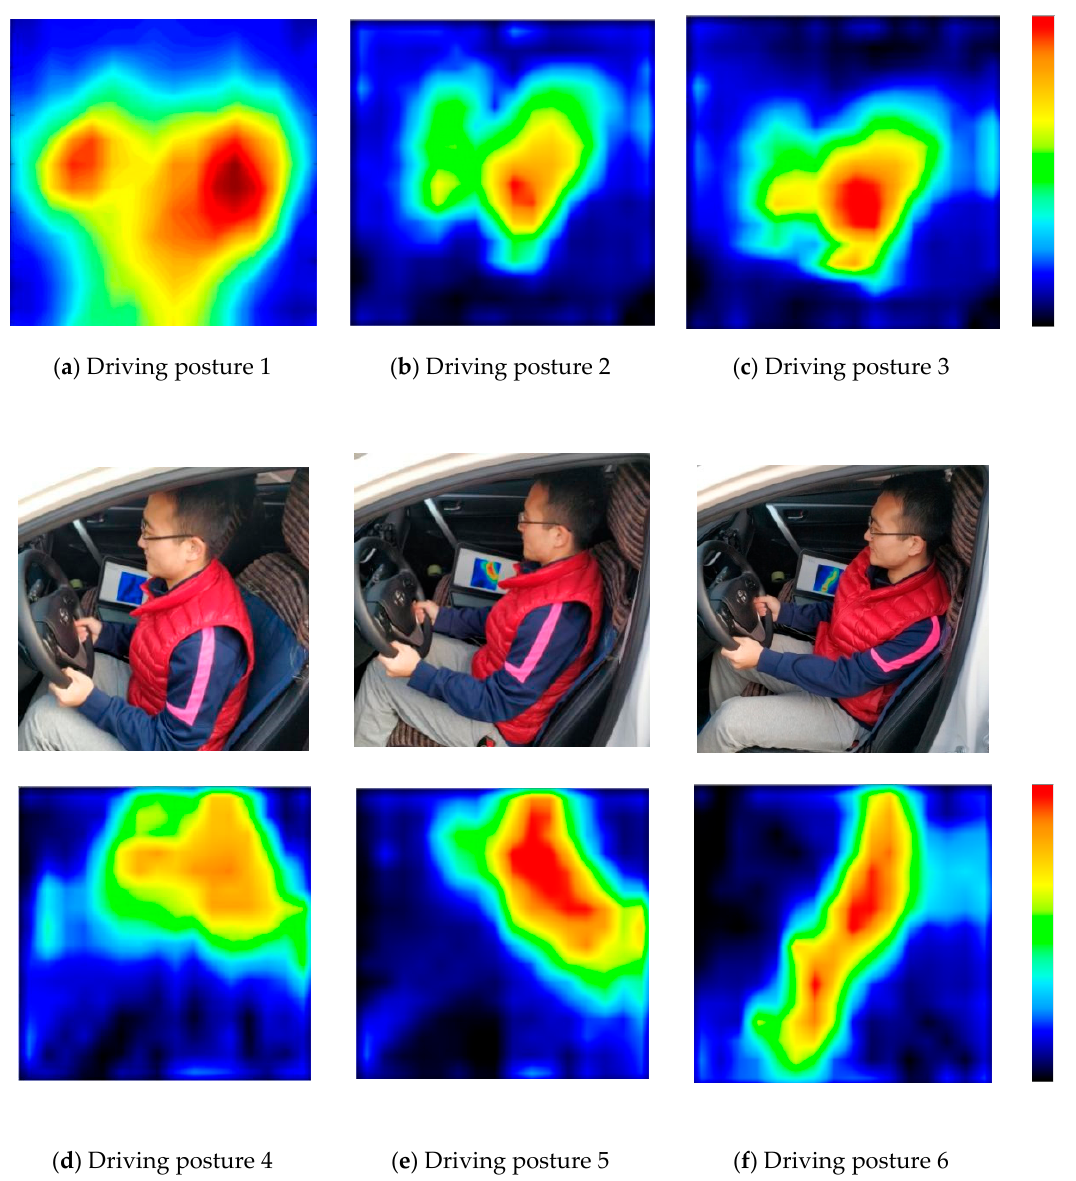
Figure 7. Sitting posture and pressure distribution of subject Figure7. Sitting posture and pressure distribution of subject 1.